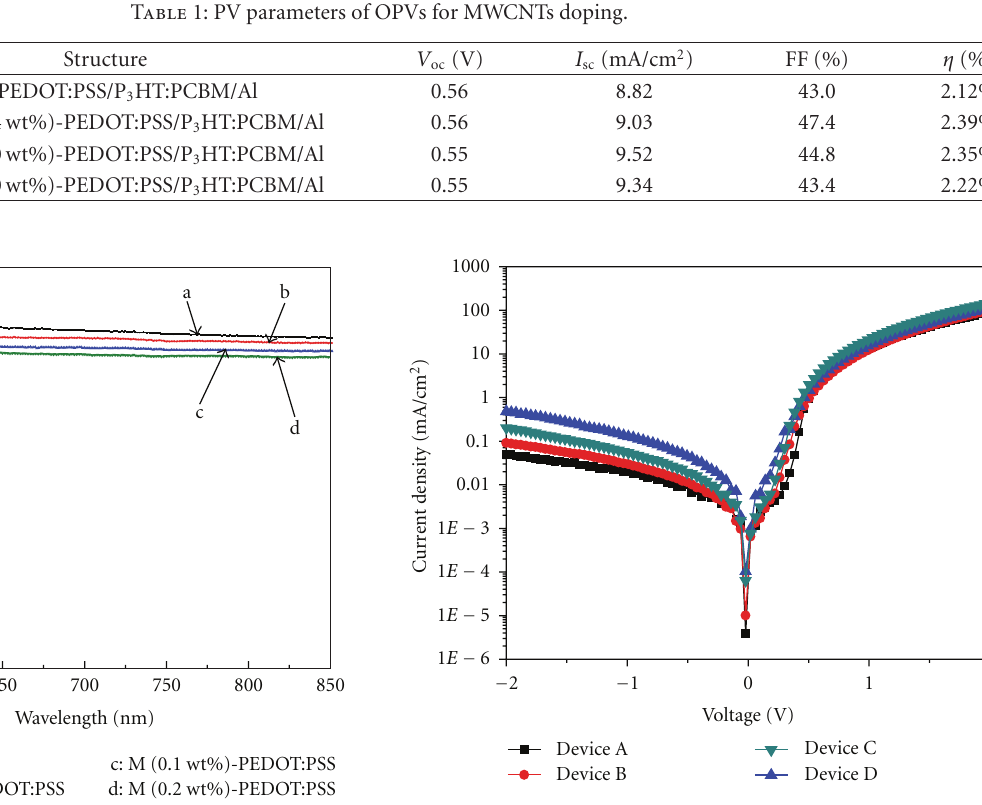
Figure 4: The dark I-V characteristics of devices with di ff erent concentrations of MWCNTs. Device A: pristine PEDOT:PSS film; Device B: M (0.04wt%)-PEDOT:PSS film; Device C: M